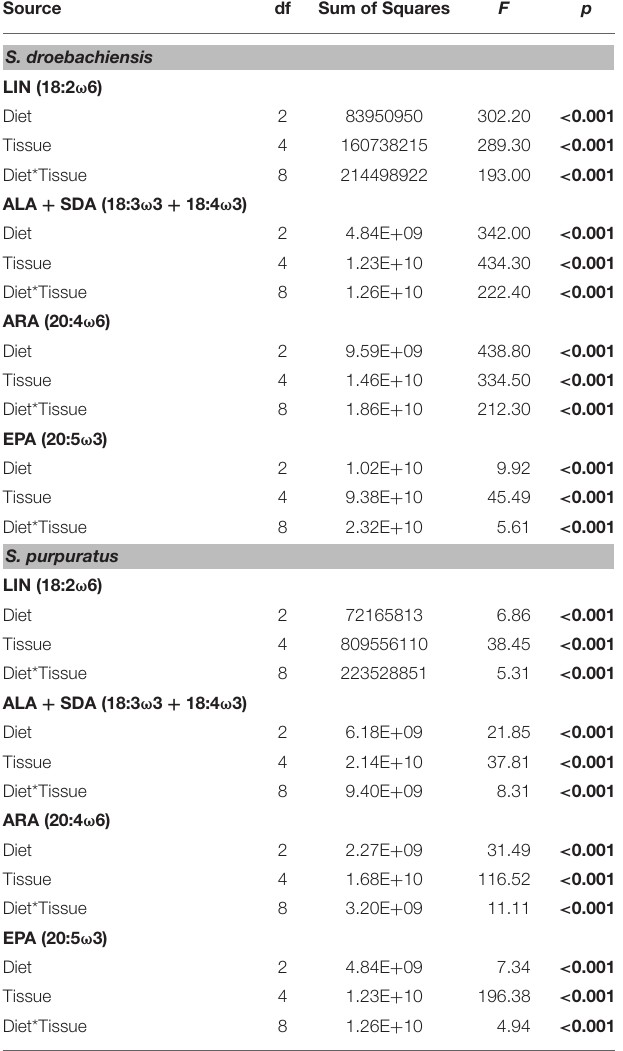
TABLE 6 | Results from 2-way analysis of variance (ANOVA) for the concentration ( µ g g − 1 dry tissue weight) of precursor (LIN and ALA + SDA) of the corresponding most abundant (ARA and EPA, respectively) long chain polyunsaturated fatty acids (LCPUFA) identified in tissues from S. droebachiensis and S. purpuratus